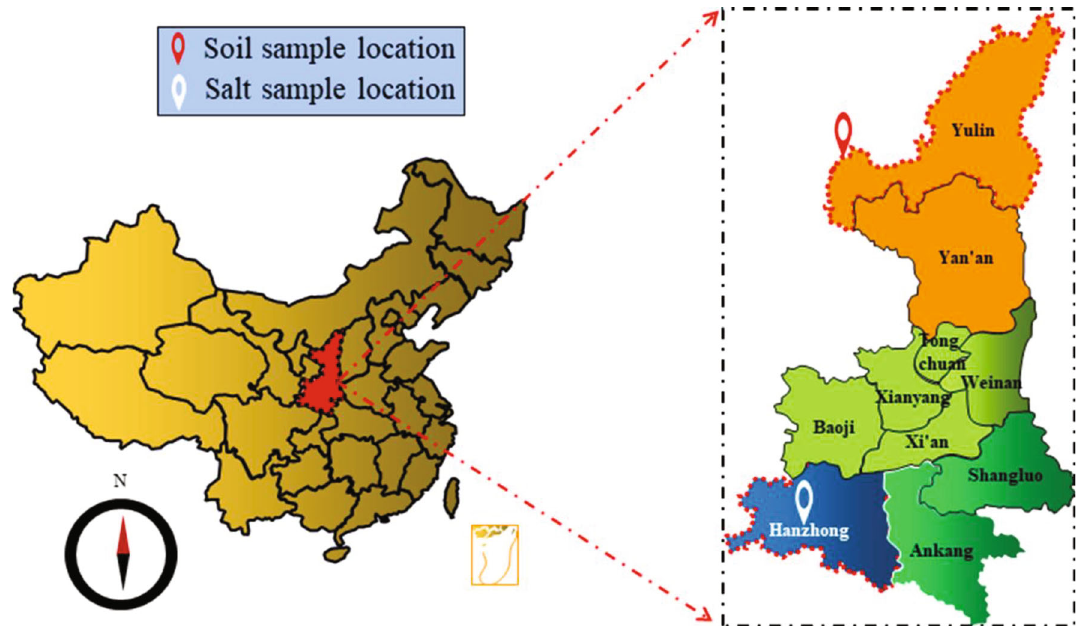
Figure 1: Schematic diagram of expansive soil and SLS sampling. Table 1: Basic physical indexes of expansive soil samples collected Table 3: Basic physical indexes of expansive soil samples under from Hanzhong. di ff erent concentrations of SLS solution.